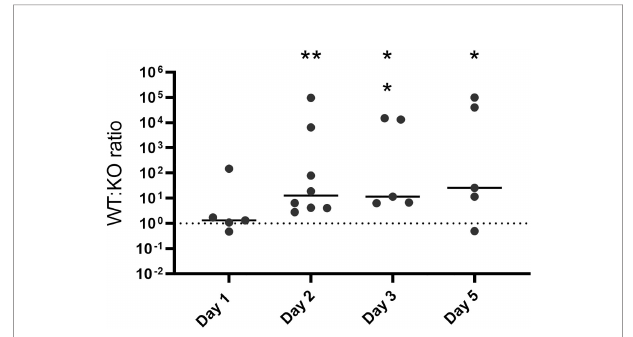
FIGURE 7 | HupZ aids GAS fi tness in mucosal colonization model. Mixtures (1:1) of WT and D hupZ mutant cells were inoculated intravaginally into mice on day 0. Vaginal lavage samples taken at days 1, 2, 3, and 5 post- inoculation were plated to determine the competitive index of WT: D hupZ mutant cells recovered. By day 2 and through to day 5, signi fi cantly fewer D hupZ mutant cells were recovered compared to WT. The data represent two independent experiments and were analyzed using the Kruskal – Wallis test of ratios, where * indicates a p -value > 0.01 and ** >